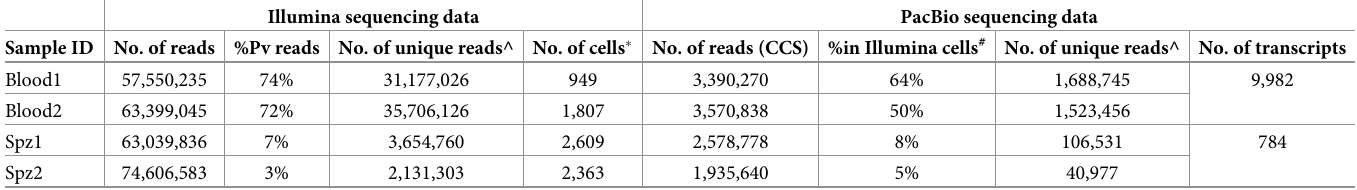
Table 1. Illumina and PacBio sequencing results and transcript predictions. Illumina sequencing data PacBio sequencing